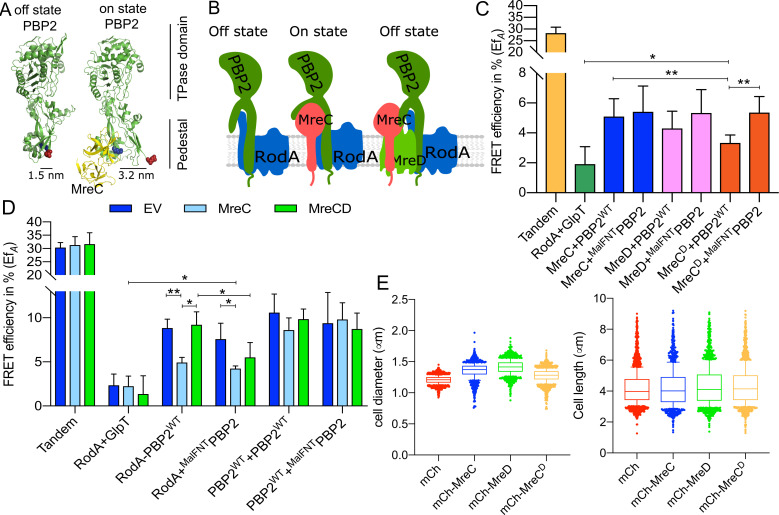
The balance of MreC and MreD affects the interaction between RodA and PBP2.a. Crystal structures of E. coli PBP2 in different conformations [40] were modeled from Helicobacter pylori PBP2 structures [39] using Phyre2 [68]. The structural information lacks the juxta-membrane, transmembrane helix and cytoplasmic regions of PBP2. MreC binds to PBP2 and was proposed to switch PBP2 from the “off state” to the “on state” [39]. The distances between the two sphered residues, (blue for Glu157) and (red for Lys60) were calculated based on the structure of PBP2 in the different conformations. b. Schematic representation of PBP2 conformational changes caused by MreC. Left panels: PBP2 stays in the “off state” in the absence of MreC (the distance between the cytoplasmic terminus of RodA and PBP2 is small); middle panels: PBP2 switches to the “on state” after binding MreC (the distance between cytoplasmic terminus of RodA and PBP2 is larger), right panels: MreD suppresses the MreC-mediated conformational change of PBP2 and keeps PBP2 in the “off state”. c. Calculated acceptor FRET efficiencies (EfA) between MreCD proteins and RodA variants from spectral FRET measurements. MreC: mCherry fused MreC; MreD: mCherry fused MreD; MreCD: MreCD co-expressed from the same plasmid, and MreC is fused with mCherry while MreD is non-fused. PBP2 and its variants are fused with mKO. d. Calculated acceptor FRET efficiencies (EfA) between RodA and PBP2 variants from spectral FRET measurements in the three-plasmids FRET experiments. EV: a third empty vector; MreC: a third plasmid expressing non-fused MreC; MreCD: a third plasmid expressing non-fused MreCD. e. Cell length and diameter changes after expressing MreC, MreD or MreCD together. LMC500 strain was transformed with each construct and grown in LB medium at 37°C and induced with 15 μM IPTG for 2 mass doublings. Proteins were expressed from the pSAV057 derived plasmids (mKO: control; MreC: mKO fused MreC; MreD: mKO fused MreD; MreCD: co-expression of MreC and MreD, MreC is fused with mKO while MreD is not fused. About 1000 cells were analyzed. P value determined with Student’s t-test (*: p<0.05; **: p<0.01:).